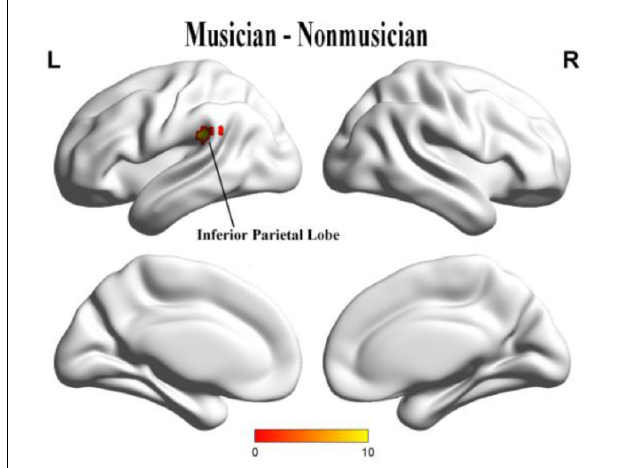
FIGURE 4 | The stronger activation of musicians to non-musicians in left IPL.